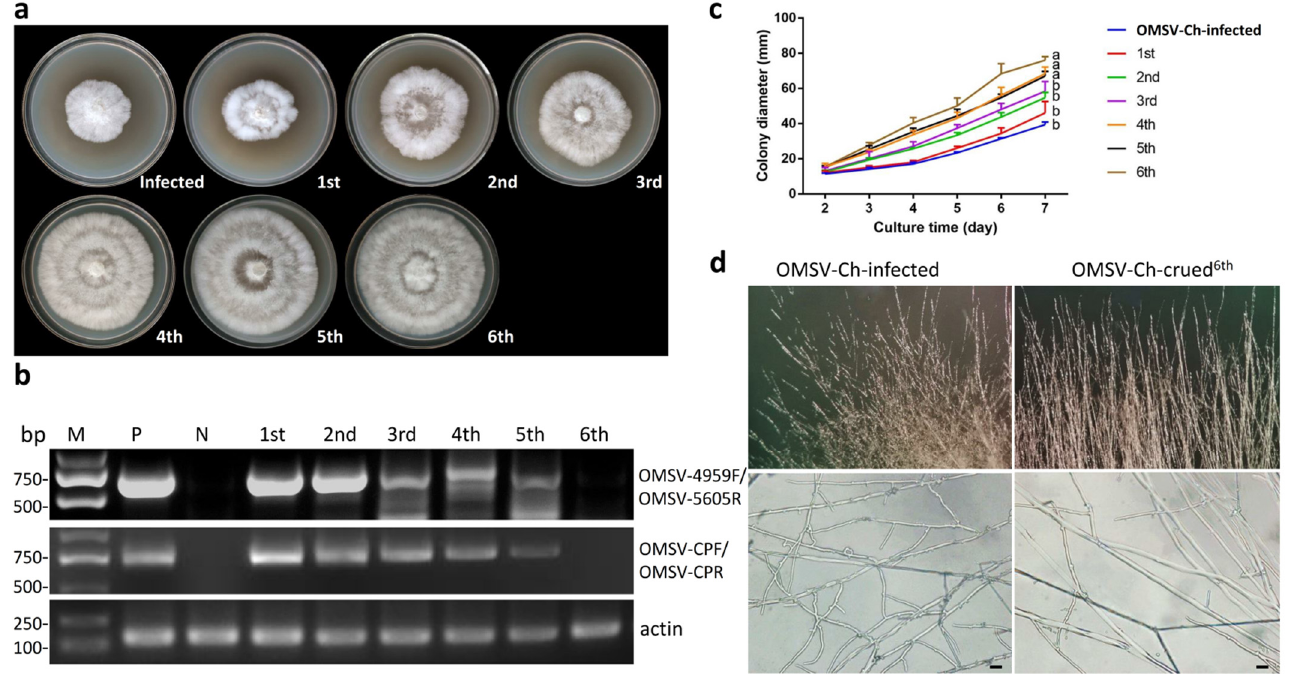
Figure 4. Curing of OMSV-Ch of P. ostreatus on PDA plates. ( a ) Colony morphology of the OMSV- Ch-infected strain compared with the OMSV-Ch-cured strain after 7 days of incubation at 25 °C. ( b ) Semi-quantitative RT-PCR detection of OMSV-Ch accumulation from each generation. The primers OMSV-4959F/OMSV-5605R (upper panel) and OMSV-CPF/OMSV-CPR (middle panel) were used for RT-PCR detection of OMSV-Ch. Actin served as an internal control (lower panel). N, negative control, the healthy P. ostreatus sample; P, positive control, the OMSV-Ch-infected P. ostreatus sample; M, GL DNA Marker2000. ( c ) Effects of OMSV-Ch curing on mycelial growth. Values are significantly different at p ≤ 0.05, by Student’s t test. ( d ) Microscopic observation of the colony margin in the OMSV-Ch-infected strain compared with the OMSV-Ch-cured strain. The fungal hyphae were observed at 400× magnification (lower panel). Bars = 20 µm.